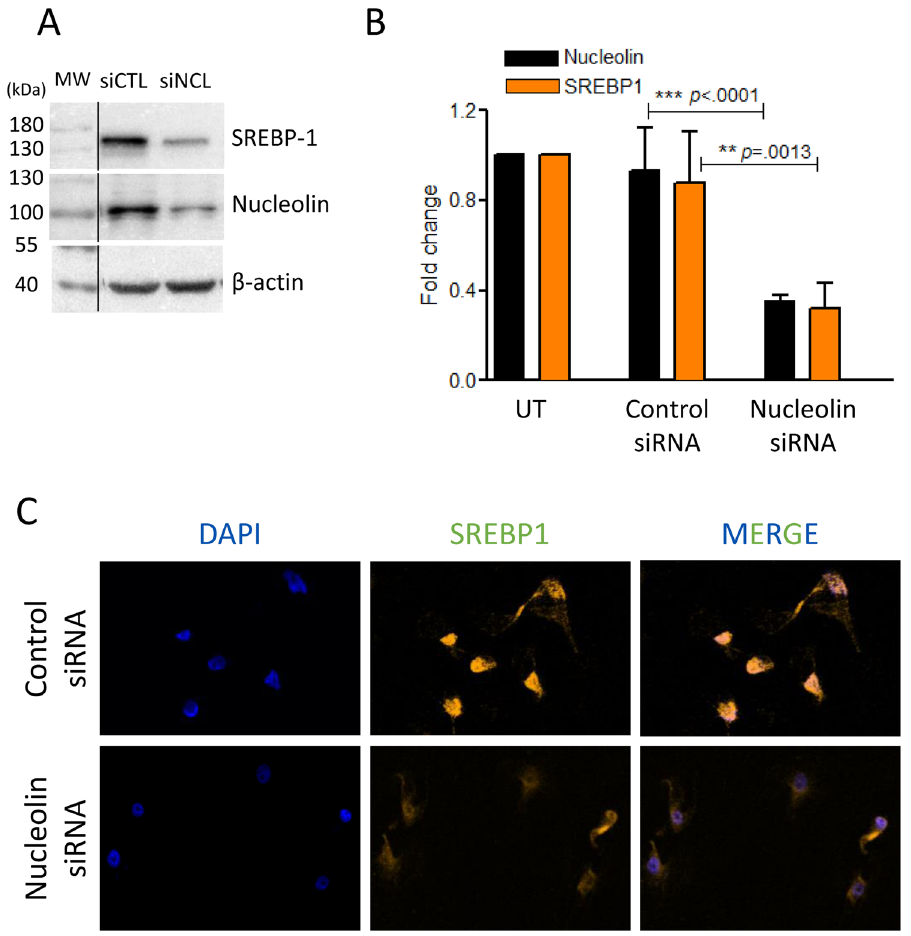
Figure 6. NCL expression affects SREBP1 accumulation and localization. ( A ) The level of SREBP1 protein was determined by western blot in cells transfected with control siRNA or with siRNA for NCL. Total extract were used and loaded onto a 10% SDS-PAGE. ( B ) Quantification of the expression of NCL and SREBP1 in untransfected cells (UT), and in cells transfected with control or NCL siRNA. Quantifications represent an average of 3 independent experiments. ( C ) Immuno-localization of SREBP1 in cells transfected with control or NCL siRNA. 96 h after transfection, cells were process for immunofluorescence with anti-SREBP1 antibody and with DAPI. Cells were then observed with confocal microscope (Zeiss